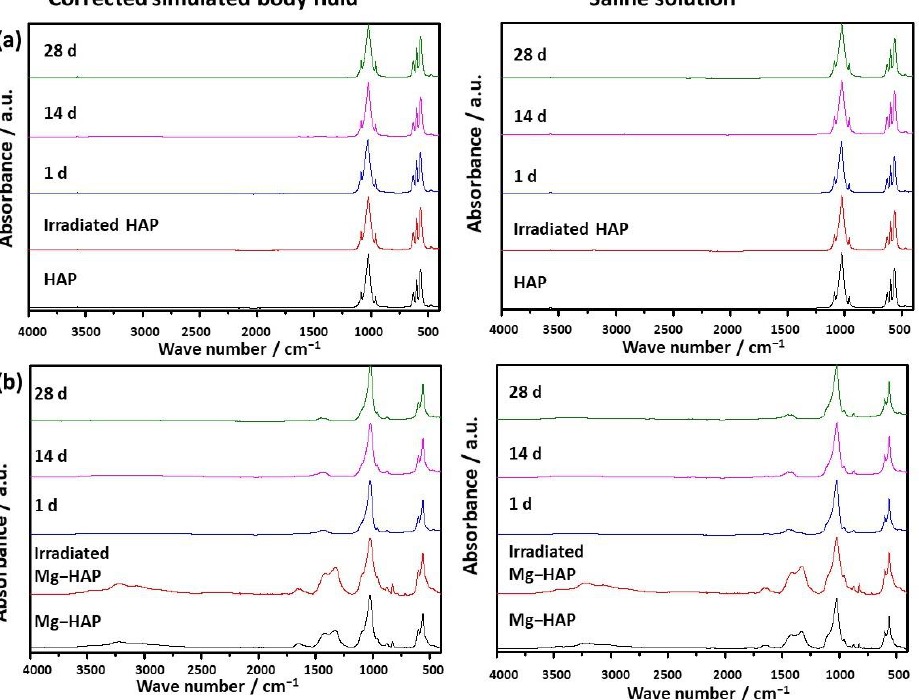
Figure 2. FTIR spectra of ( a ) non-substituted hydroxyapatite (HAP) and ( b ) Mg-substituted HAP (Mg-HAP) starting powder, powder irradiated to 25 kGy, and powders after immersion in corrected simulated body fluid (c-SBF) and saline solution (SS) for 1 – 28 days at 37 °C.